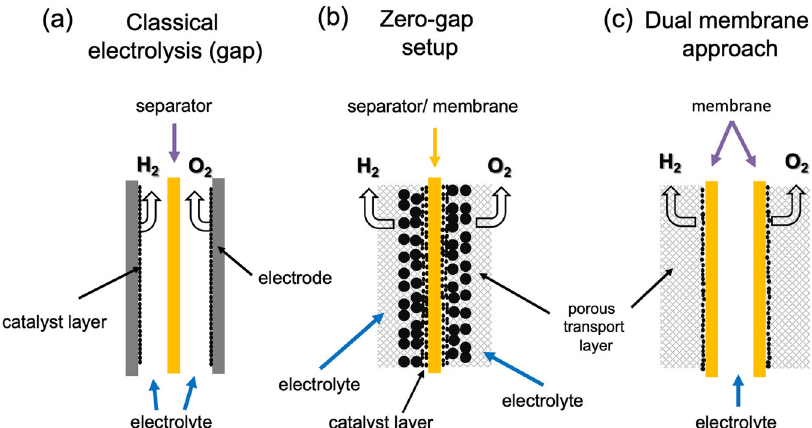
Fig. 1 Design of electrolyzer cells. a Classical electrolysis setup with a separator and two electrodes separated by a fi nite distance, ( b ) zero- gap setup with catalysts and porous transport layers and ( c ) dual-membrane cell which could potentially be suitable for low-g applications. In contrast to layouts ( a ) and ( b ), liquid electrolyte/water is fed in layout ( c ) between two membrane